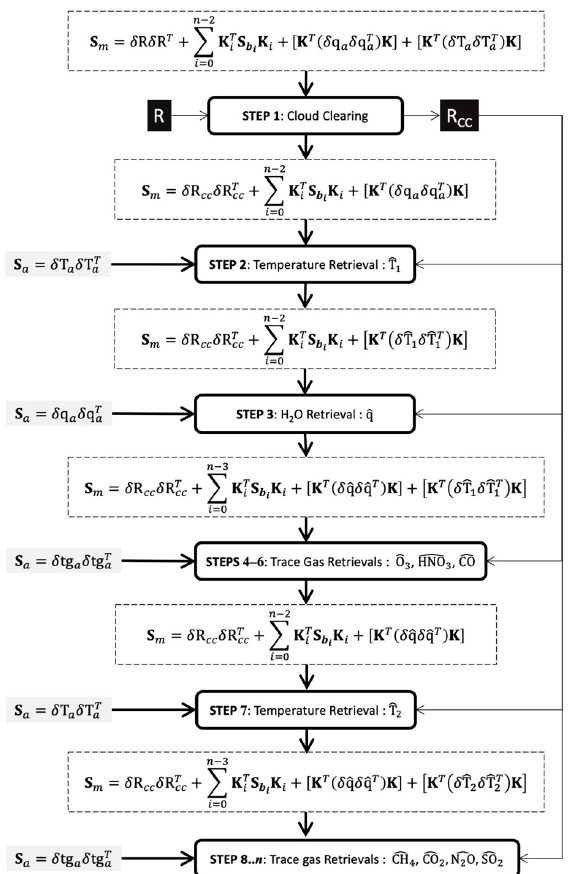
Figure 1. Flow diagram of the CLIMCAPS sequential retrieval process and propagation of scene-dependent uncertainty for a specific datum, or instrument footprint at a specific time. Step 1 involves the retrieval of cloud properties (amount and cloud top pressure) that are used to clear the cloud signal from the measured radiance spectrum (R). All subsequent profile variables (temperature, water vapor and trace gases) are retrieved from this “cloud cleared” radiance spectrum (R CC ), the sequence of which is in a specific order. The most linear inversion, namely temperature (𝐓(cid:3553)) , is done first (Step 2). Once the scene-specific temperature is known, water vapor (𝐪(cid:3549)) is retrieved followed by ozone , carbon monoxide and nitric acid (Steps 3 through 6). With the scene-specific trace gas quantities now known, temperature can be retrieved a second time, but with more spectral channels because the uncertainty due to interfering gases can be quantified precisely (Step 7). The remainder of the CLIMCAPS greenhouse and precursor gases are then retrieved (Steps 8 through n ). Each retrieval step employs a unique subset of R CC channels. The CLIMCAPS Bayesian retrieval approach depends on the definition of two error covariance matrices, one for the a priori estimate ( S a ) and another for the radiance measurement ( S m ) . S a is calculated o ff -line as a statistical ensemble uncertainty and remains static from datum to datum as well as through all the retrieval steps. S m , on the other hand, is datum-specific and updated at each step. S m is an aggregate term of the random instrument noise, systematic channel correlations, forward model uncertainty as well as uncertainty due to interfering background state variables ( S b ) . This diagram highlights the propagation for temperature and water vapor retrieval uncertainty specifically and therefore do not group these terms with the background error term. Matrix K is the forward model weighting function, or partial derivative of the forward model with respect to the retrieval variable. This sequential retrieval approach with scene-dependent error propagation linearizes each retrieval step as much as possible to promote product stability with known uncertainty estimates in clear and cloudy